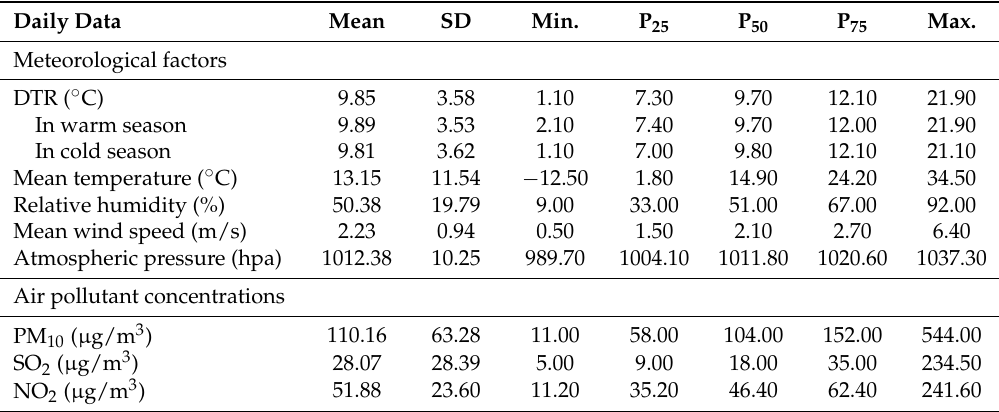
Table 2. Summary statistics of daily meteorological factors and air pollution concentrations in Beijing